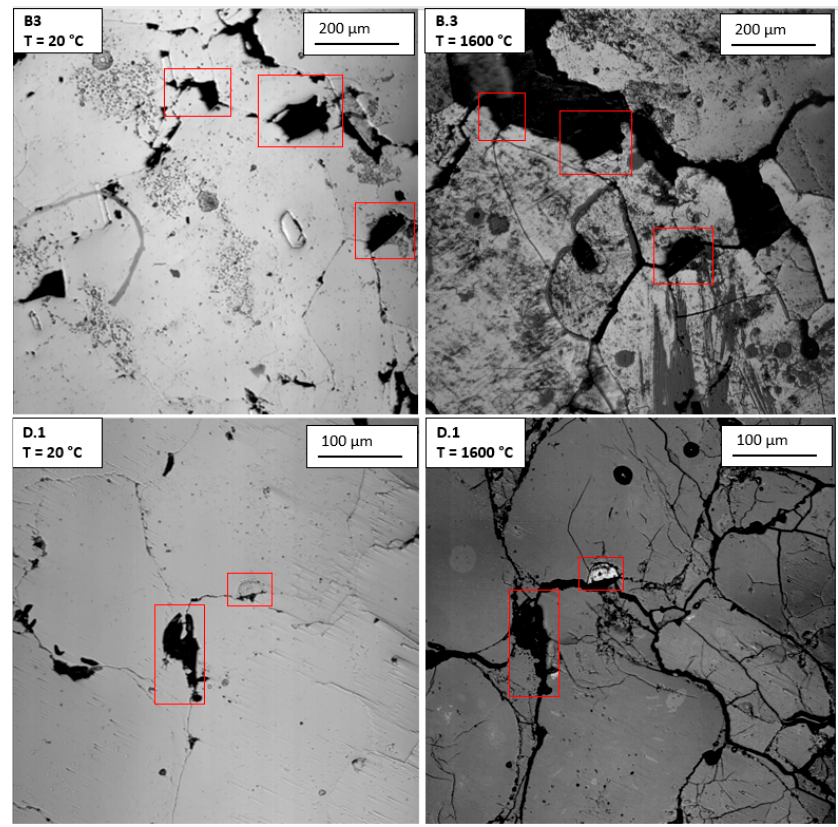
Figure 3. Images from high temperature confocal microscope (HTCM) experiment B.3 and D.1 at 20 °C and 1600 °C, showing the visual changes in the impurity areas after heating.